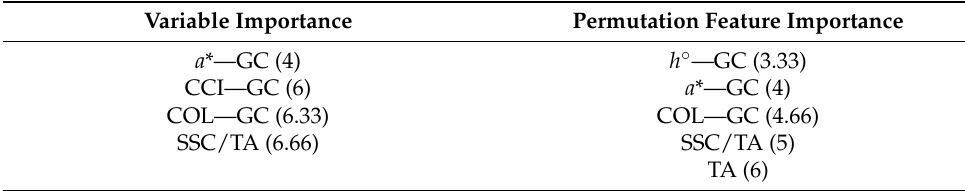
Table 7. Summarization of variables that are among top 10 most contributing in all three ROSE balanced models (Models A, B, and